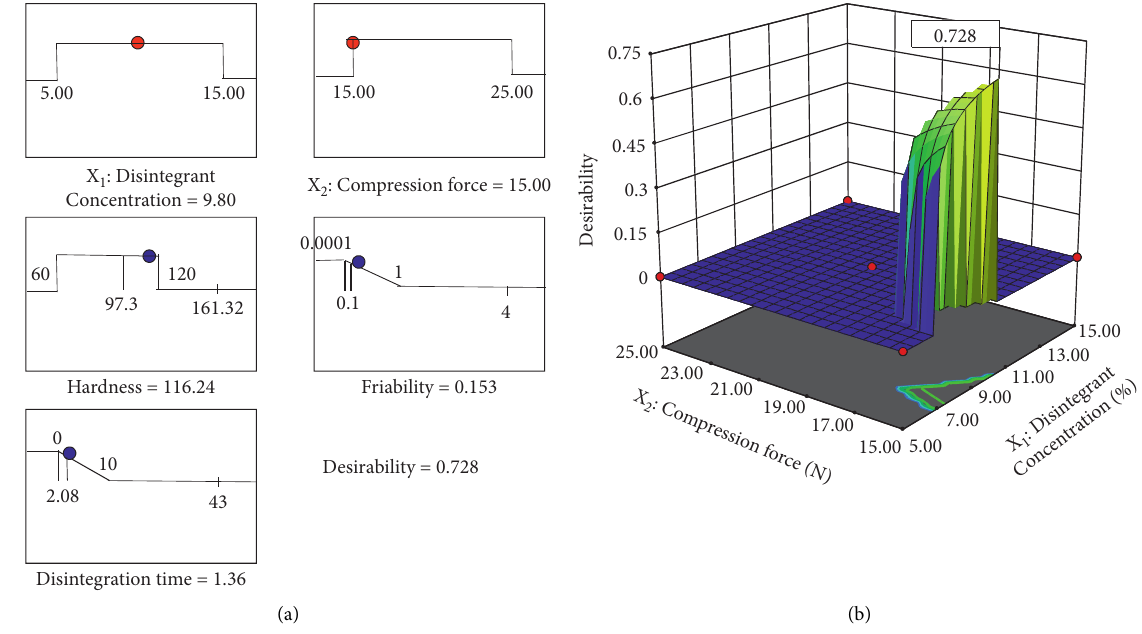
Figure 5: The ramps of optimization (a) and the overall desirability function (b). Overlay Plot